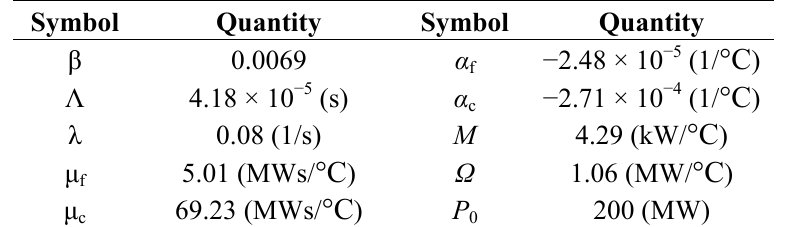
Table 1. NHR Parameters at the Middle of the Fuel Cycle in 100% Power-Level.